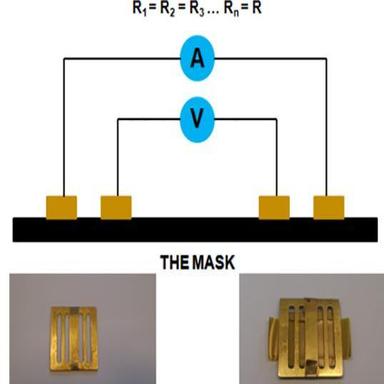
The scheme showing the surface conductivity measurement using the four-point method. A – the current flow between the external electrodes, V – the measured potential between the internal electrodes. The following shows the mask which was used for the deposition of Au for electric contact in the measurements.